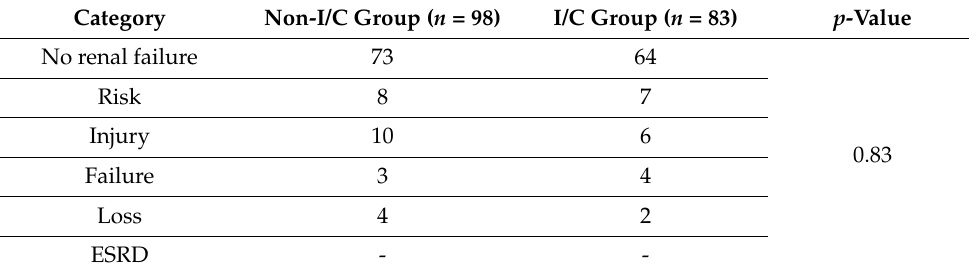
Table 3. RIFLE Table 3. RIFLE classification.